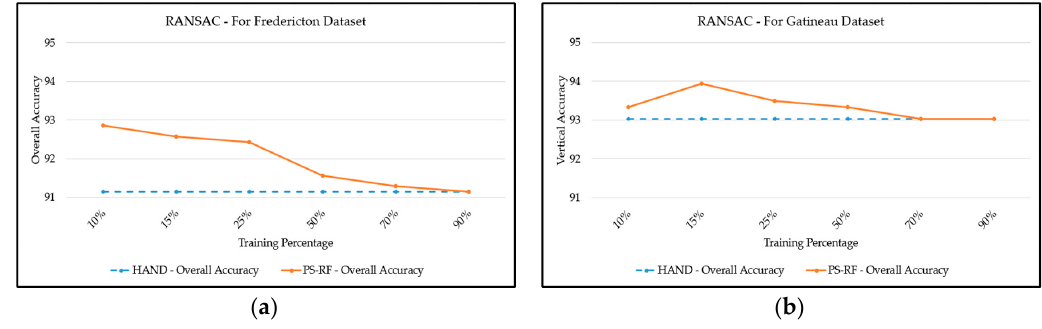
Figure 11. The overall accuracy of different training percentages over validation dataset tested for Fredericton ( a ) and Gatineau ( b ) datasets.